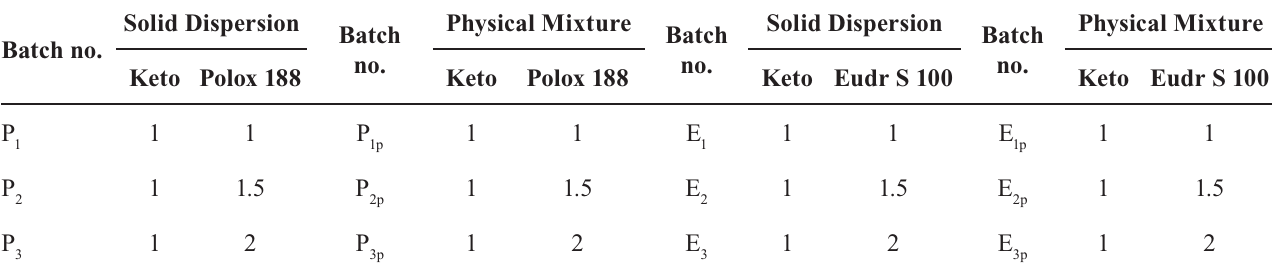
TABLE I - D rug & polymer conc. ratio for solid dispersions and physical mixtures